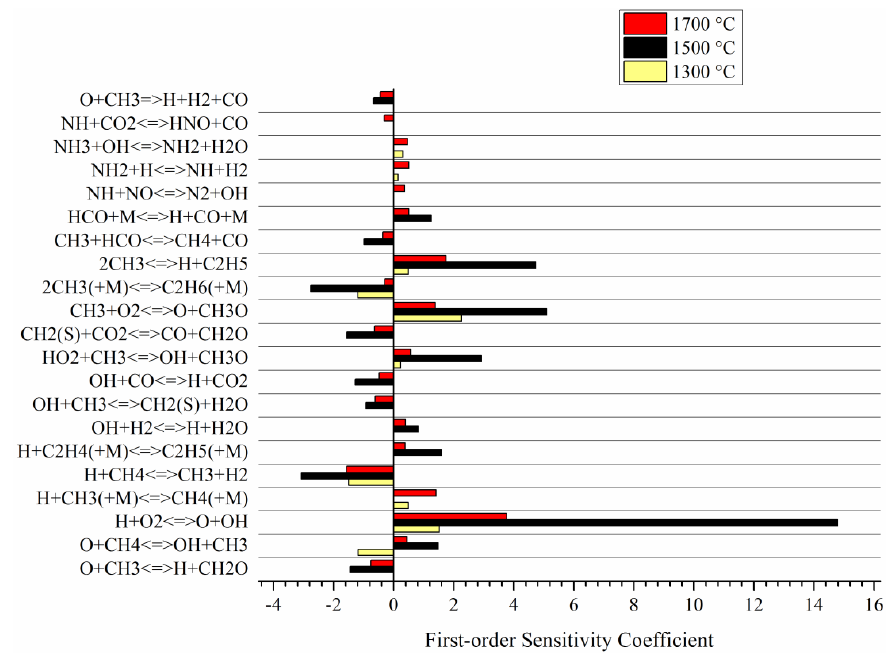
ff erent temperatures in O 2 at di